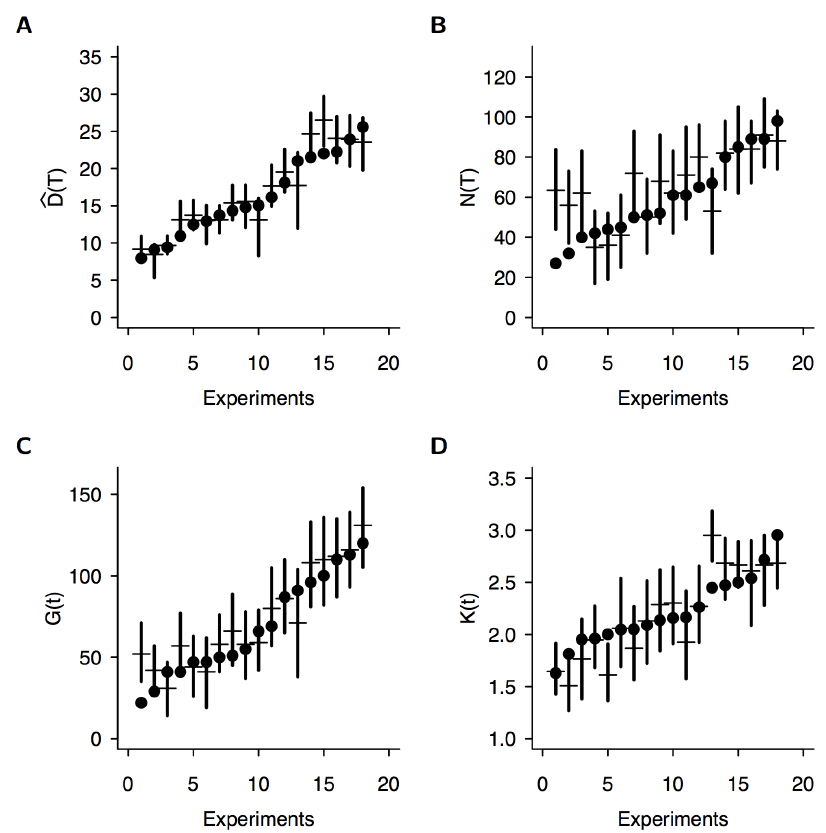
Figure 3. The structural properties of the observed networks at the end of experiments after three days (one symbol per experiment) are well predicted by the model for (a) the length ^ DD ( T ) , (b) the number of nodes N ( T ) , (c) the number of tunnels G ( T ) and (d) the mean degree K ( T ) . In each plot, vertical bars indicate 95% confidence interval predicted by the model and were numerically estimated using simulations (N=2000 simulations per experiment using the corresponding set of behavioural parameters). Horizontal bars indicate the predicted median. Note that experiments have been ordered by increasing ordinate values.